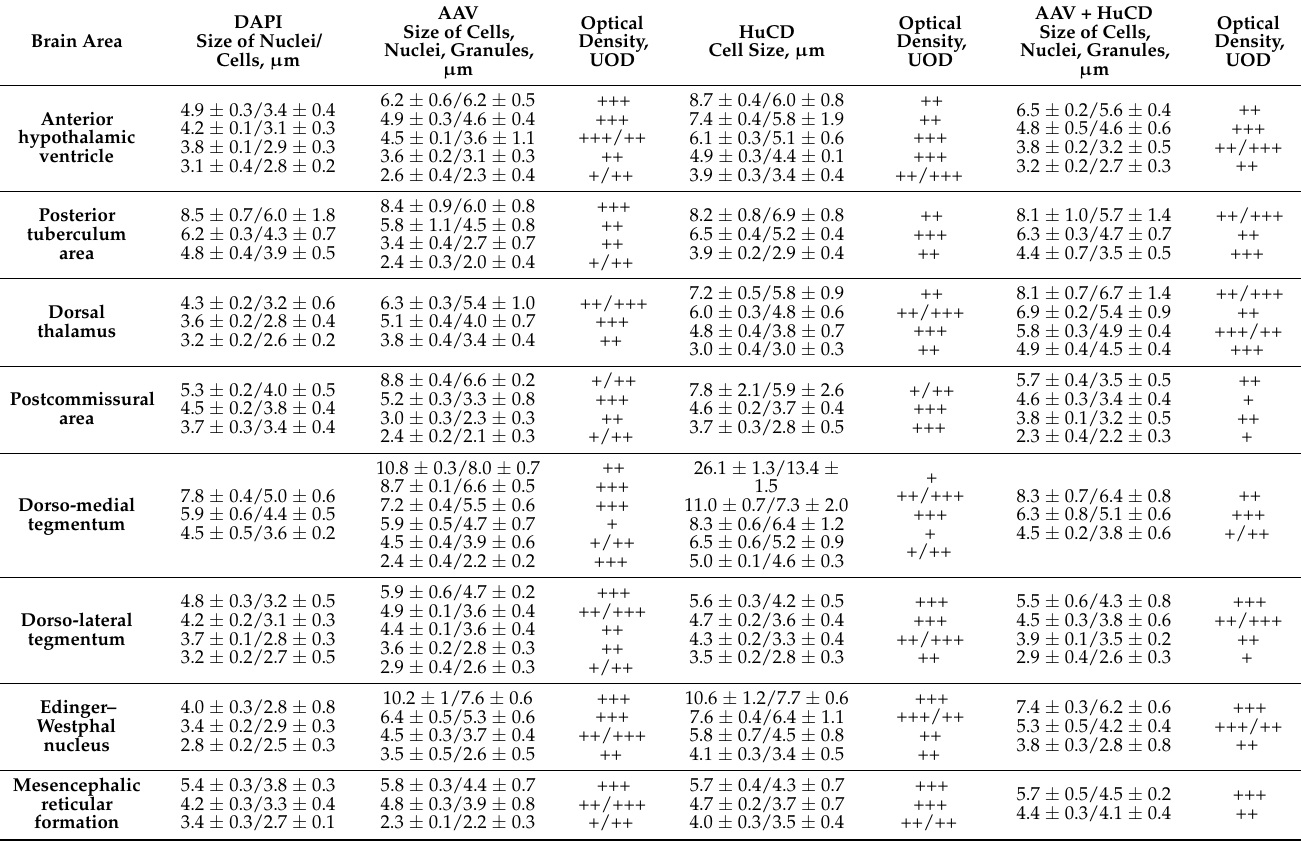
Table 1. Morphometric parameters * of labeled neurons (M ± SD) in the mesencephalic tegmentum of the juvenile chum salmon, O. keta , one week after a single injection of the adenoviral